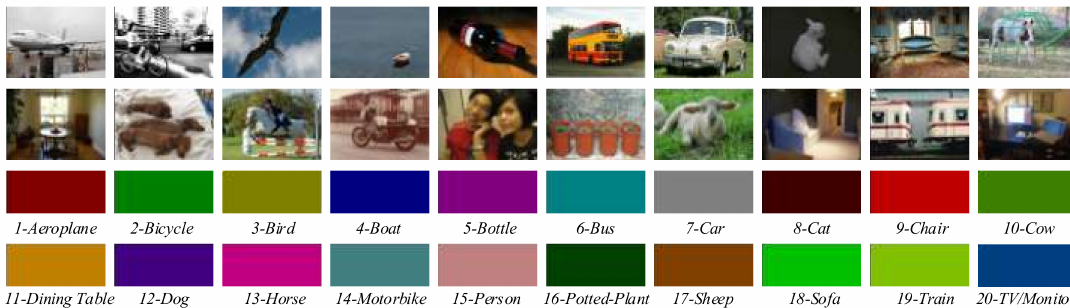
Figure 5. PASCAL VOC 2012 dataset of 20 categories, numbers, and color